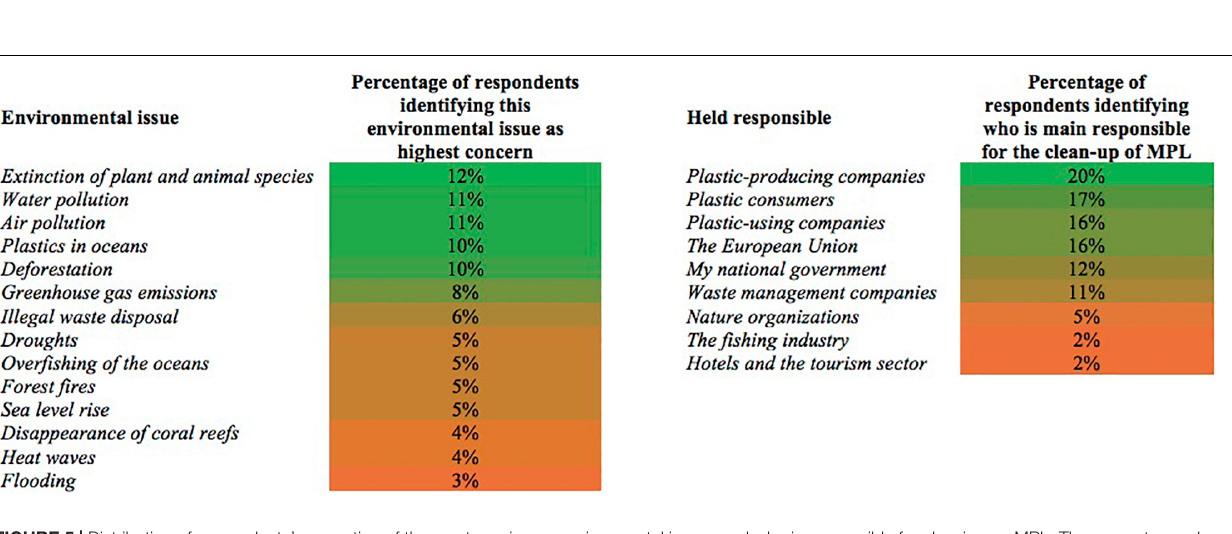
FIGURE 5 | Distribution of respondents’ perception of the most worrisome environmental issues and who is responsible for cleaning up MPL. The percentages do not add up to 100% due to rounding errors.